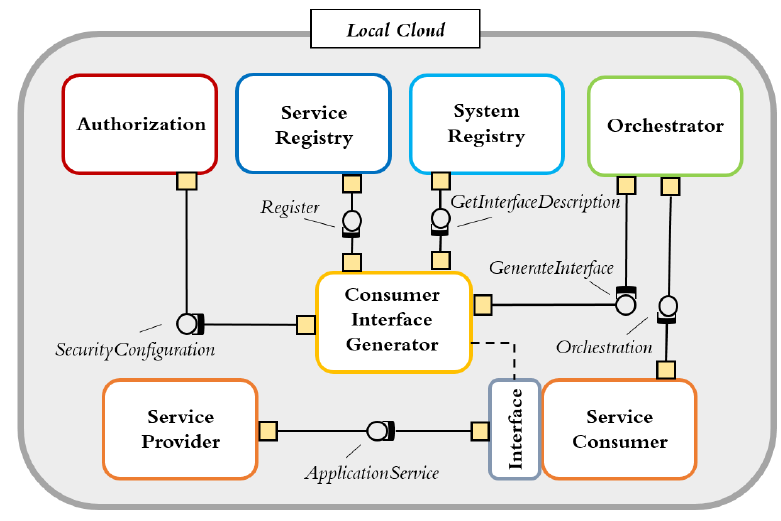
Figure 2. An example of an Arrowhead local cloud where consumer interface generation systems are used to generate a new interface between a service provider and a service consumer.